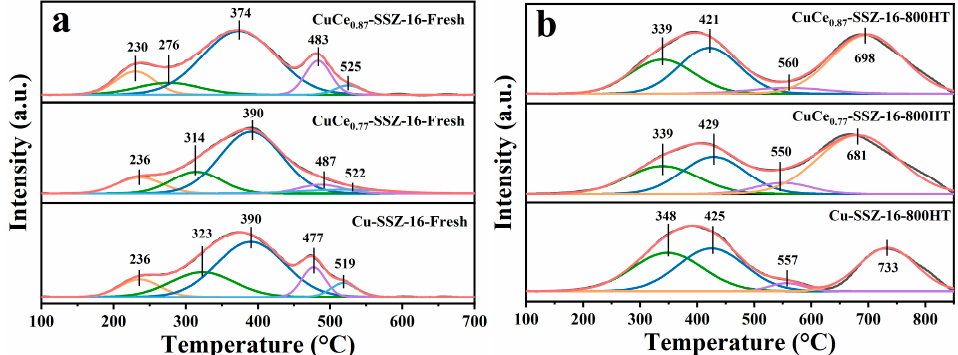
Figure 9. H 2 -TPR before ( a ) and after hydrothermal treatment at 800 ◦ C ( b ) of Cu-SSZ-16, CuCe 0.77 - SSZ-16, and CuCe 0.87 -SSZ-16. Table 4. The distribution of Cu species measured by H 2 -TPR.